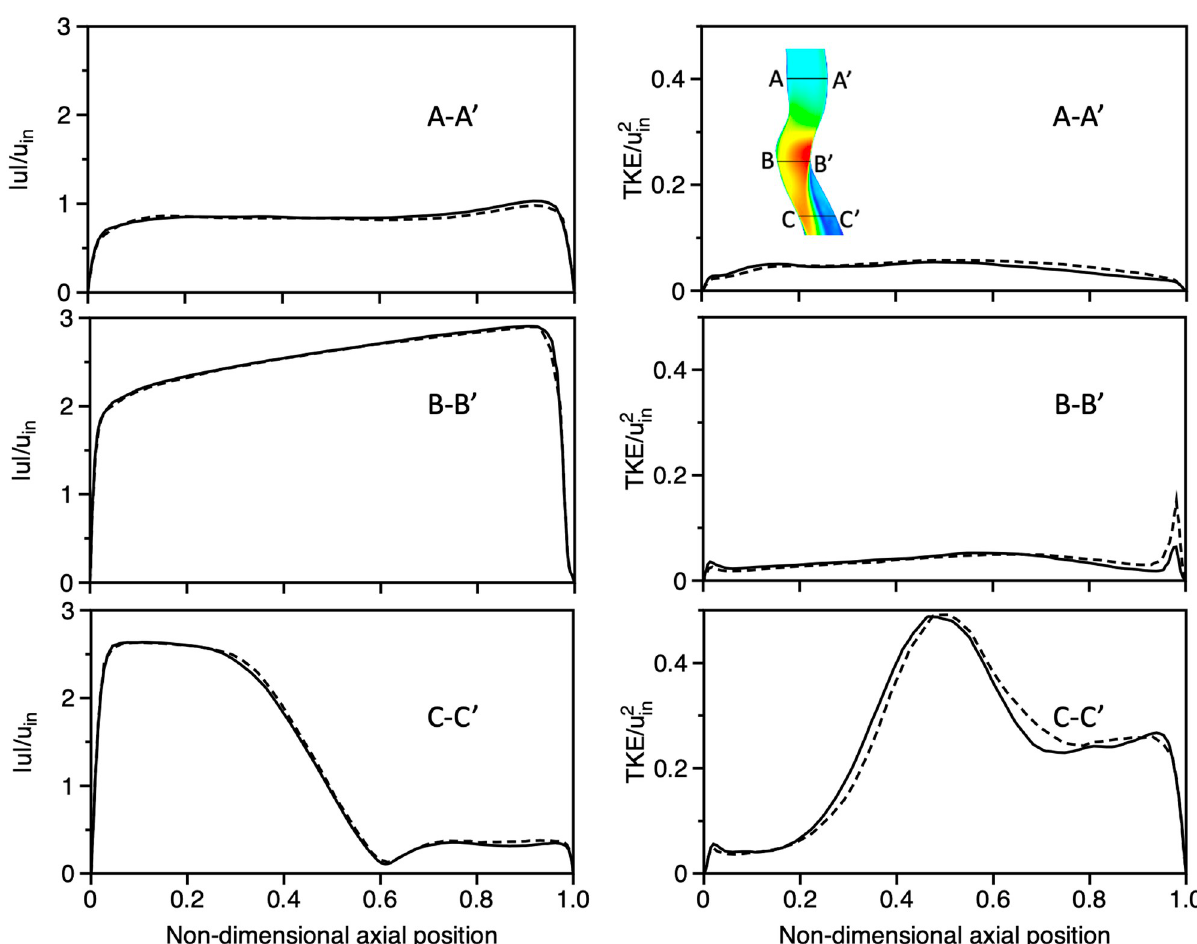
Fig 2. Large Eddy Simulation (LES) grid sensitivity analysis (Re = 7’000). Comparison of 1D profiles of normalized time-averaged velocity magnitudes (first column) and turbulent kinetic energy (second column), normalized by the mean inlet velocity u in , are presented at three stations (see inset; top right panel) along the larynx (A-A’), glottis (B-B’) and upper trachea (C-C’), respectively, for two grid resolutions: (i) coarse (9.2M cells) and (ii) fine (25M cells).